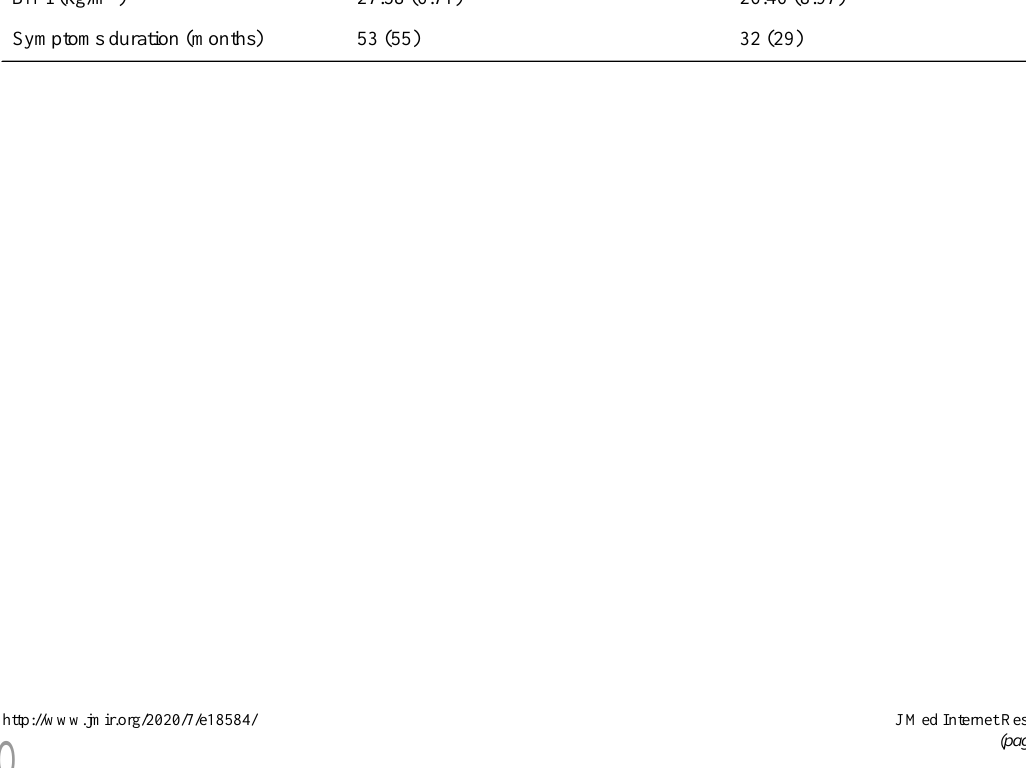
Quality of Life subscale b , range: 0-100)